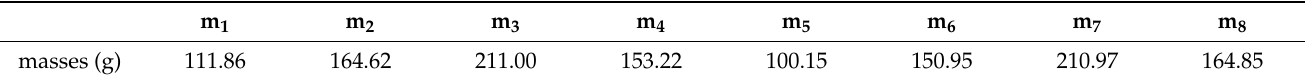
Figure 1. Setup attachment for tests at an angle of 90 ◦ with prestress. The plateau of the attachment viewed in an angled perspective from the top ( a ). The base of a clamp viewed from the top ( b ) and from the bottom ( c ). The lid of a clamp viewed from the top ( d ) and the bottom ( e ). Table 1. Masses of the weights for the attachment at 90 ◦ with prestress in gram, which were already calculated in our prior study [7]. The masses 1–8 are mentioned clockwise starting with the one on the opposite of the cannula’s